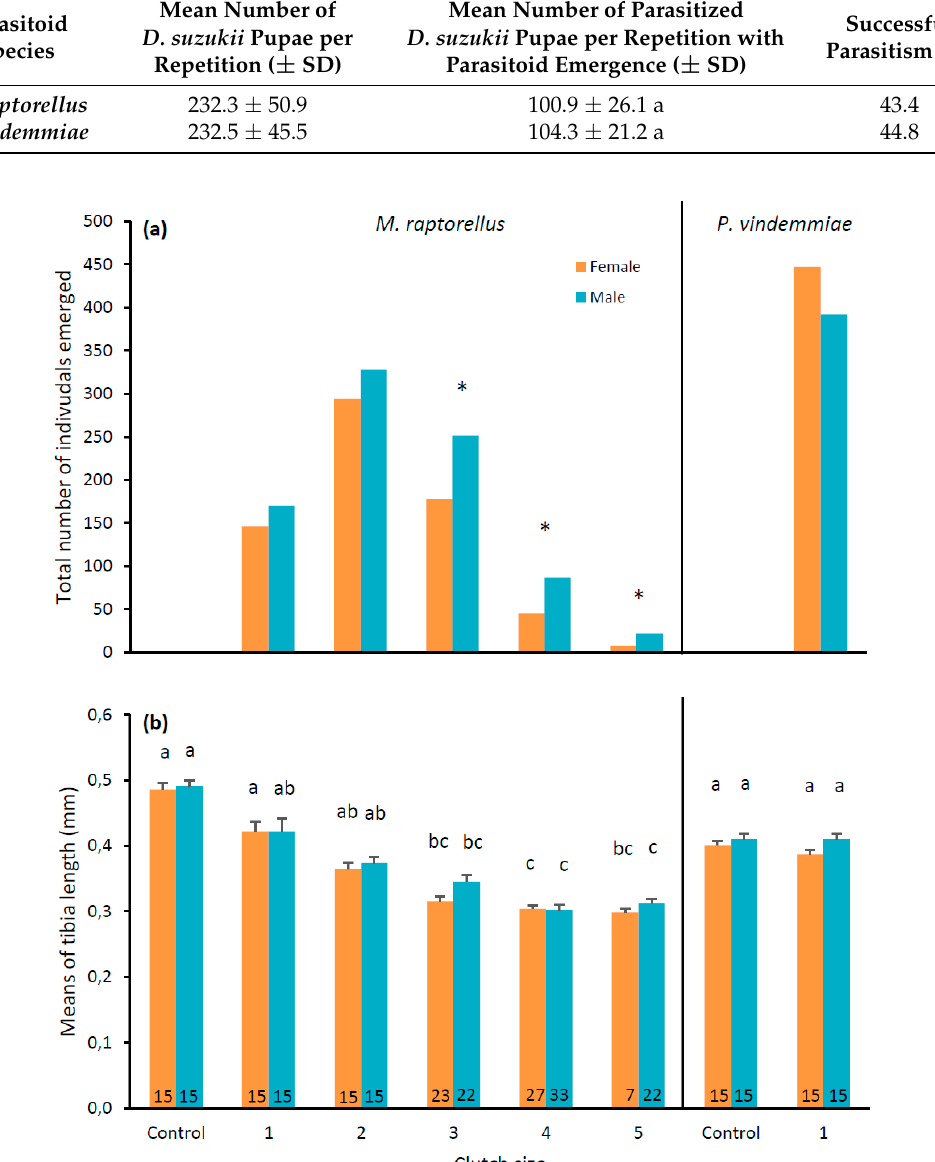
Table 1. Successful parasitism for each pupal parasitoid wasp species ( n = 18) when exposed to D. suzukii developing in raspberries in the laboratory. Mean numbers of parasitized pupae with the same letter were not significantly different (Student’s t -test, p < 0.05).